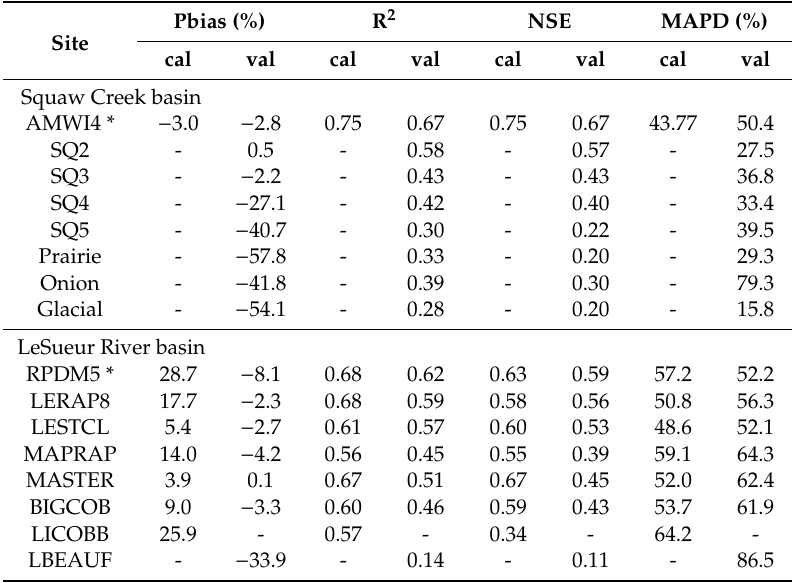
Figure 2. Simulated vs. observed discharge hydrographs for basin outlets for March–September 2008, which is during the calibration period. Table 5. Percent bias (Pbias), coefficient of determination (R 2 ), Nash-Sutcliffe efficiency (NSE) and mean absolute percent deviation (MAPD) for the calibration (cal) and validation (val) period for model runs using NLDAS-2 forcing. * Denotes basin outlet.